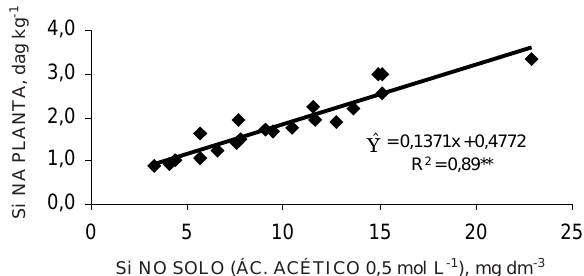
Figura 2. Teores de Si nas folhas do arroz de sequeiro em função do Si extraído do solo pelo